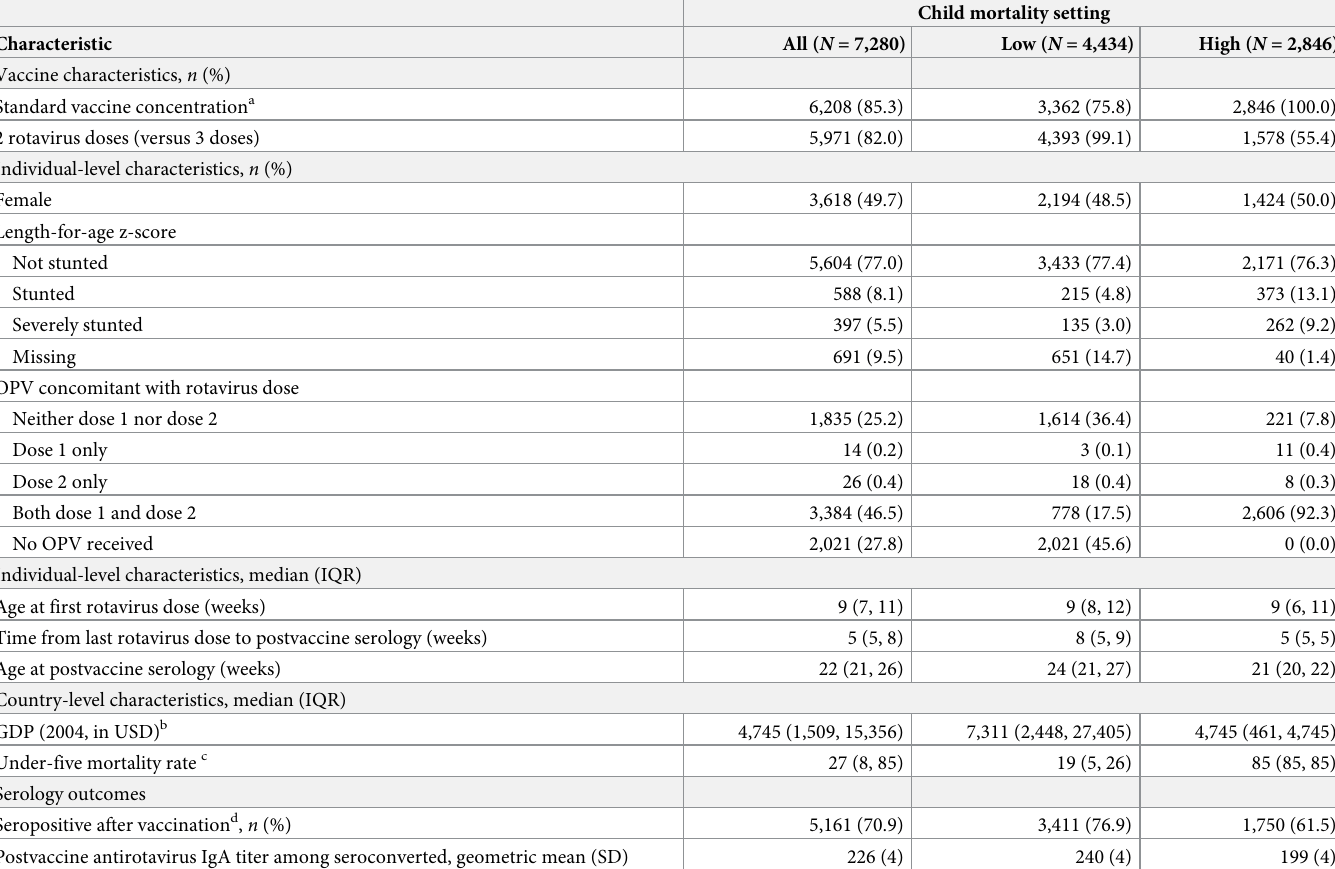
Table 3. Vaccine and individual- and country-level characteristics of infants from 22 trials conducted in 33 countries/territories beginning in